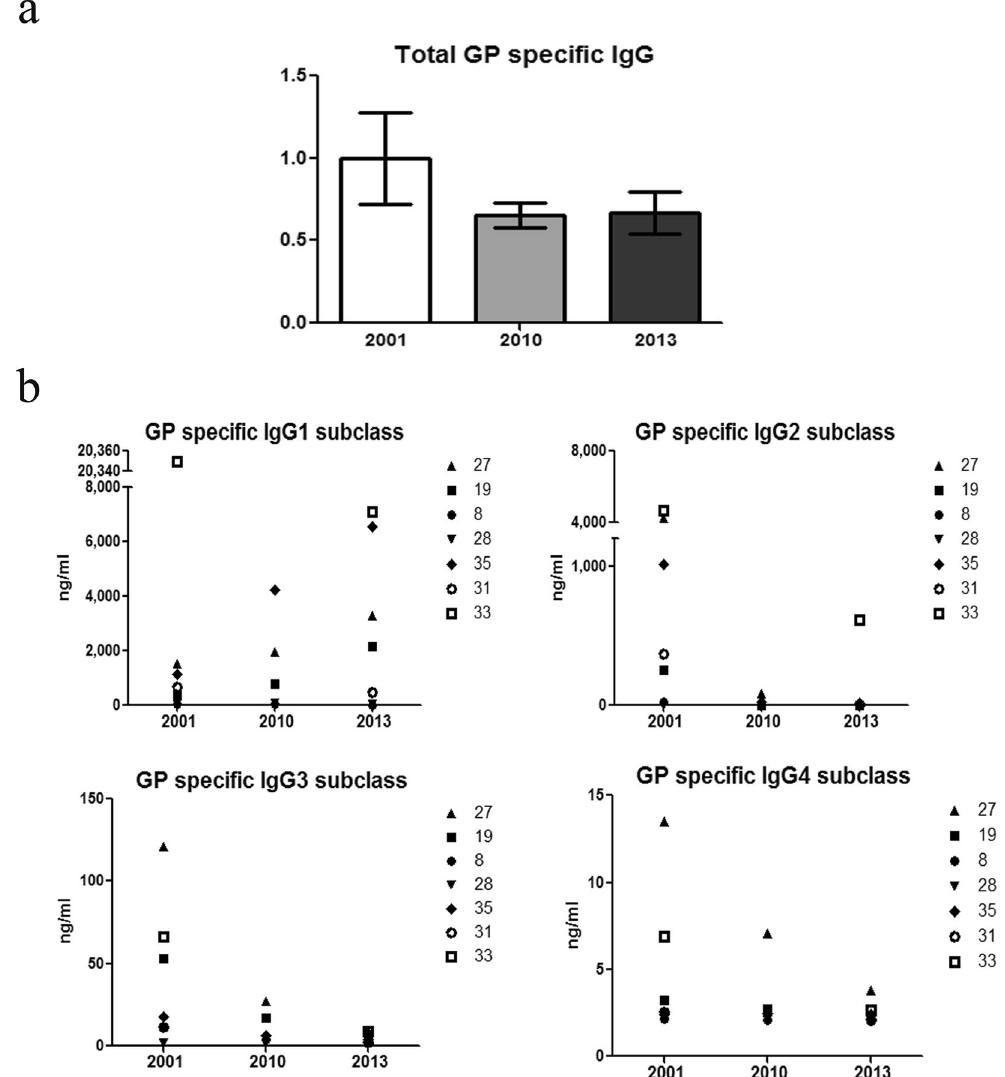
Figure 5. Analysis of total GP-specific IgG, and IgG subclasses in sera from SUDV survivors. To test total levels of GP-specific IgG ( a ) and IgG subclasses ( b ) in sera samples of SUDV survivors from the longitudinal study (2001-2010-2013), plates were pre-coated with GP-Gulu antigen (5 μ g/ml), washed, blocked and seeded with sera samples (triplicates) diluted 1:100 for subclass analysis and 1:400 for total IgG analysis. Total levels of GP- specific IgG from 2010 and 2013 normalized to the level of GP-specific IgG from